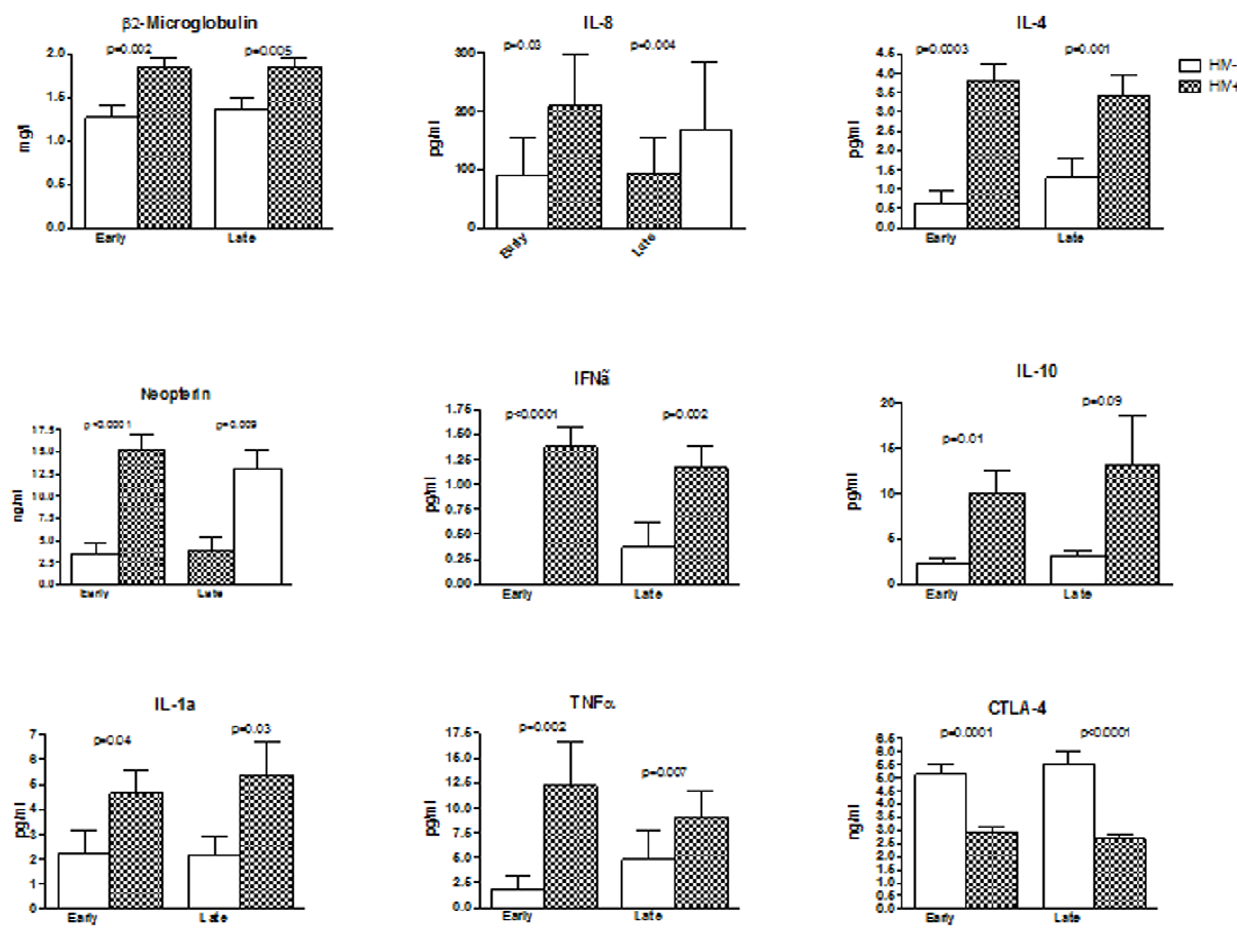
Figure 3. Inflammatory factors and other cytokines in HIV-infected and uninfected women during early and late gestation. Bars represent means and SEM. The analytes are indicated in the graph titles. Significant differences between HIV-infected and uninfected women are indicated by the p values immediately above the bars (Mann Whitney).